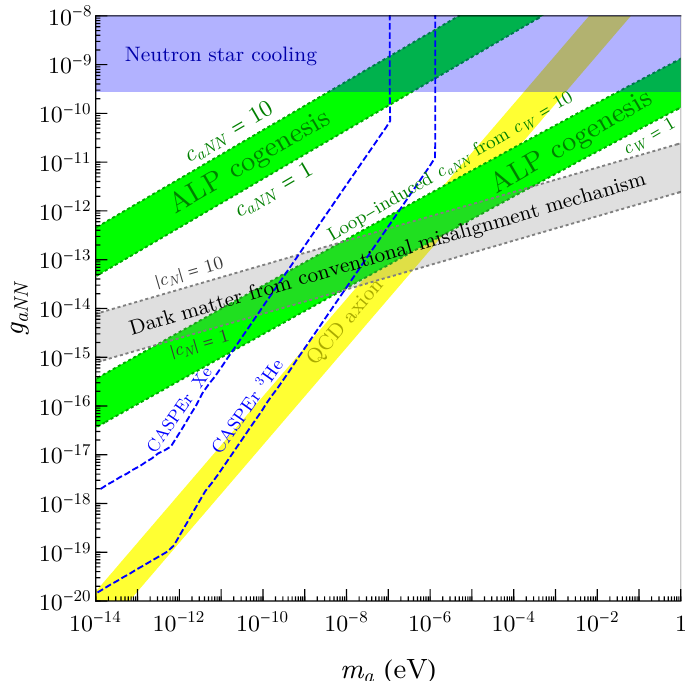
Figure 2 . The prediction for the ALP-nucleon coupling g aNN is shown for c aNN = 1 (cid:0) 10 in the upper green band and for loop-induced c aNN from c W = 1 (cid:0) 10 in the lower green band. The predictions for the QCD axion and for ALP dark matter from the conventional misalignment mechanism are shown in the yellow and gray bands. The blue shaded region shows the constraint from neutron star cooling, while the blue dashed lines show the sensitivity of the planned experiment